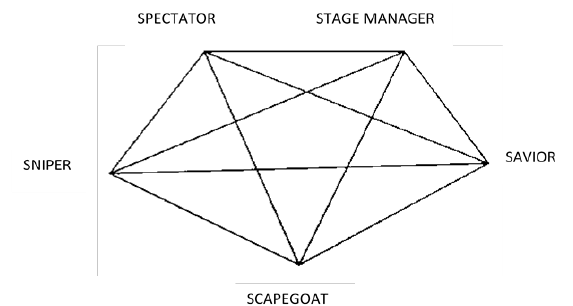
Figure 3: Game Pentagon Summerton 1992 p.